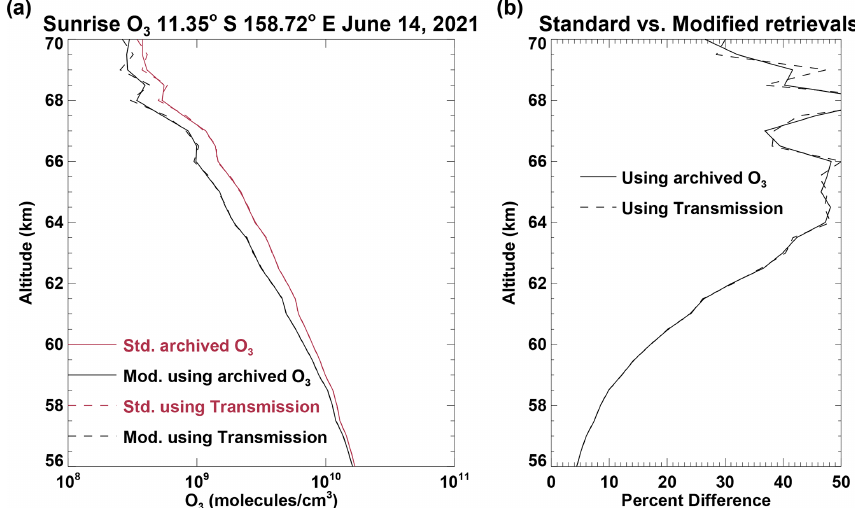
Figure 7. SAGE III/ISS O 3 for a sunrise event at 11.35 ◦ S and 158.72 ◦ E on 14 June 2021 (Event ID 2021061438SR). (a) Red solid line shows the standard SAGE III retrieval, and the black solid line represents the retrieval including the diurnal variations along LOS. The dashed lines represent the retrievals using the transmission data, the red color for the standard retrieval and the black denoting the retrieval with diurnal corrections. (b) Percent difference between the standard retrieval and the one with diurnal corrections; solid line using the archived standard retrieval of O 3 concentration, and the dashed line based on the approximate retrieval using the transmission data.